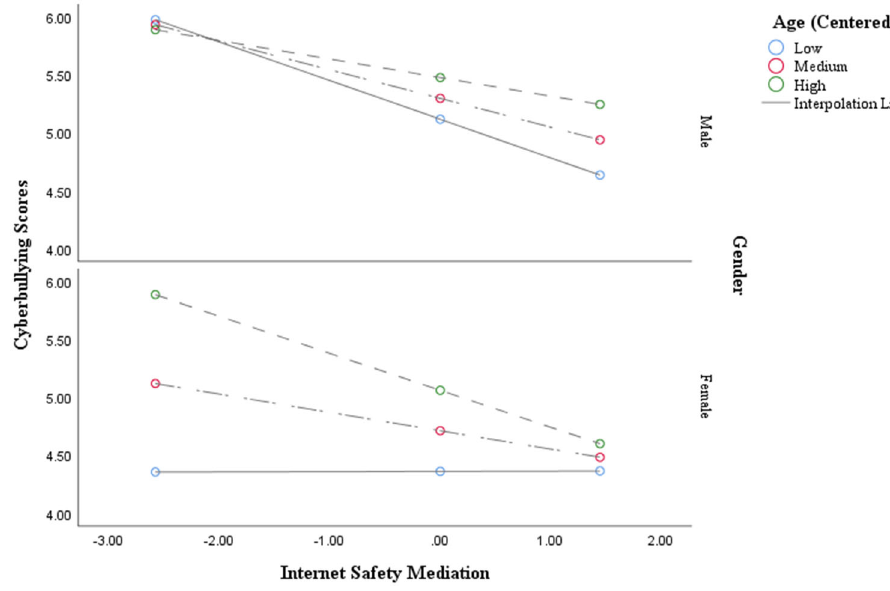
Fig. 3 Graphical representation of three-way interaction between Internet safety mediation, age, and